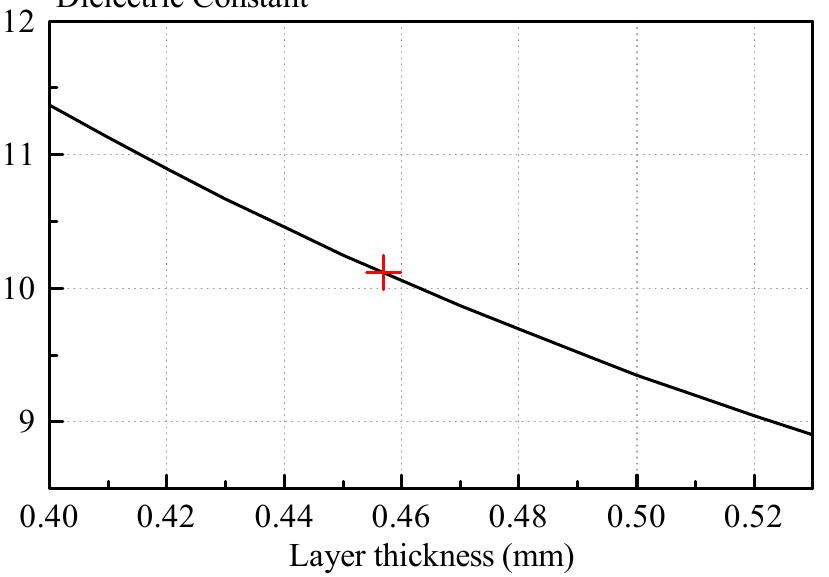
Figure 17. Dielectric constant measurement of the 60% weight percent BST sample with varying input thicknesses for the calculation software. The nominal averaged thickness of the sample is 0.457 mm with a calculated dielectric constant of 10.14.